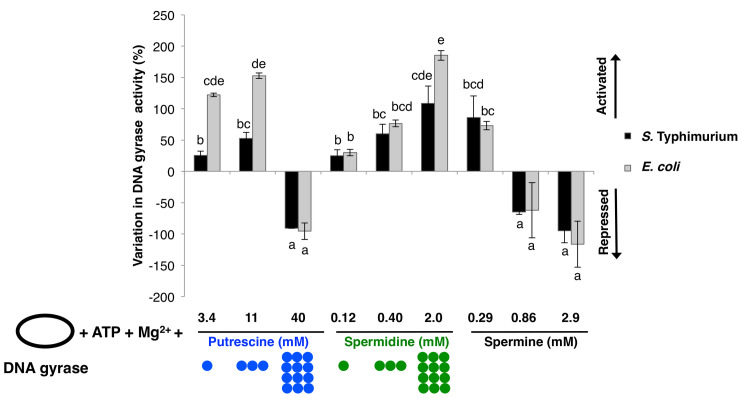
Polyamines regulate the in vitro activity of the purified DNA gyrases from S. Typhimurium and E. coli.Topoisomerase-treated plasmid DNA was incubated with purified DNA gyrase alone (reference for 0% variation in DNA gyrase activity) and with the indicated amounts of each polyamine. The experiment was performed with the DNA gyrases from E. coli and (separately) from S. Typhimurium. DNA gyrase activity was calculated as ΔLk/hour from agarose/chloroquine gels and normalized to the activity of the purified DNA gyrase without polyamines. Coloured circles quantitatively represent added concentrations of putrescine (blue) or spermidine (green). Lowercase letters indicate pairwise statistical significance (Tukey’s HSD, p<0.05, n = 2).